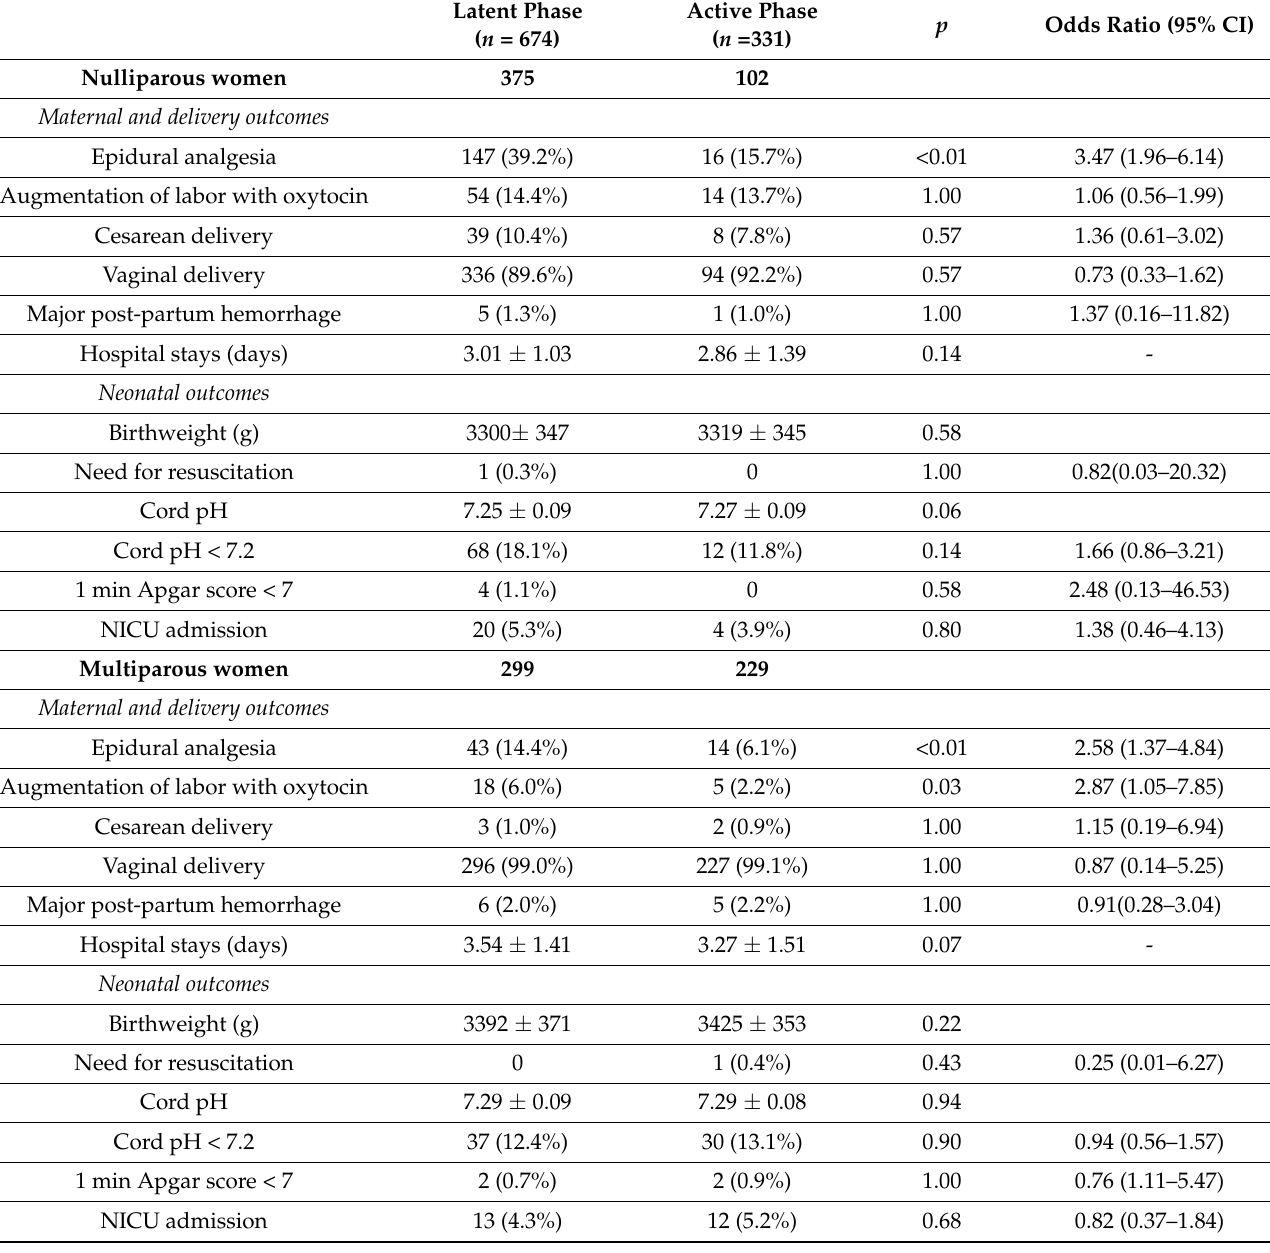
Table 2. Comparison of maternal and neonatal outcomes between women admitted in the latent- phase and those admitted in the active phase of labor. NICU, neonatal intensive care unit. Latent Phase ( n =